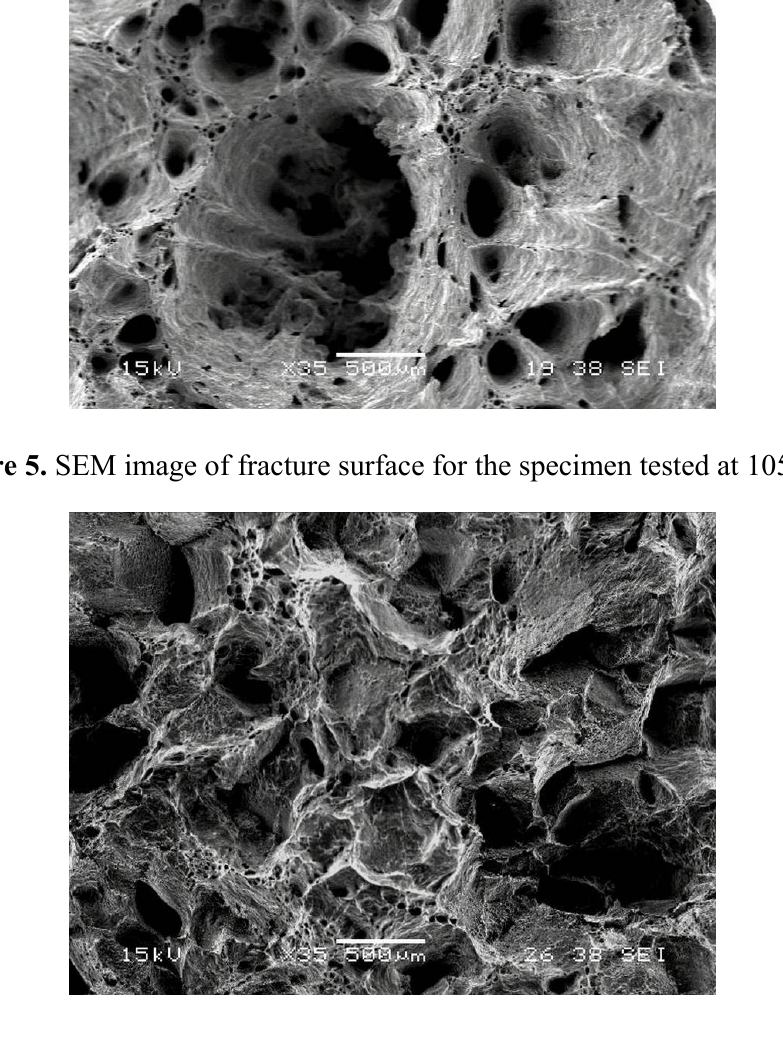
Figure 6. SEM image of fracture surface for the specimen tested at 1000